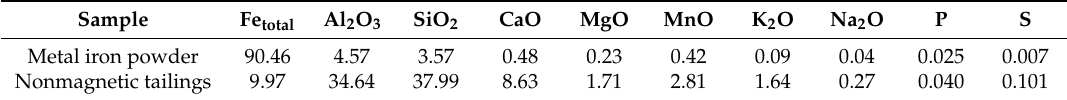
Table 3. Chemical compositions of final products (wt.